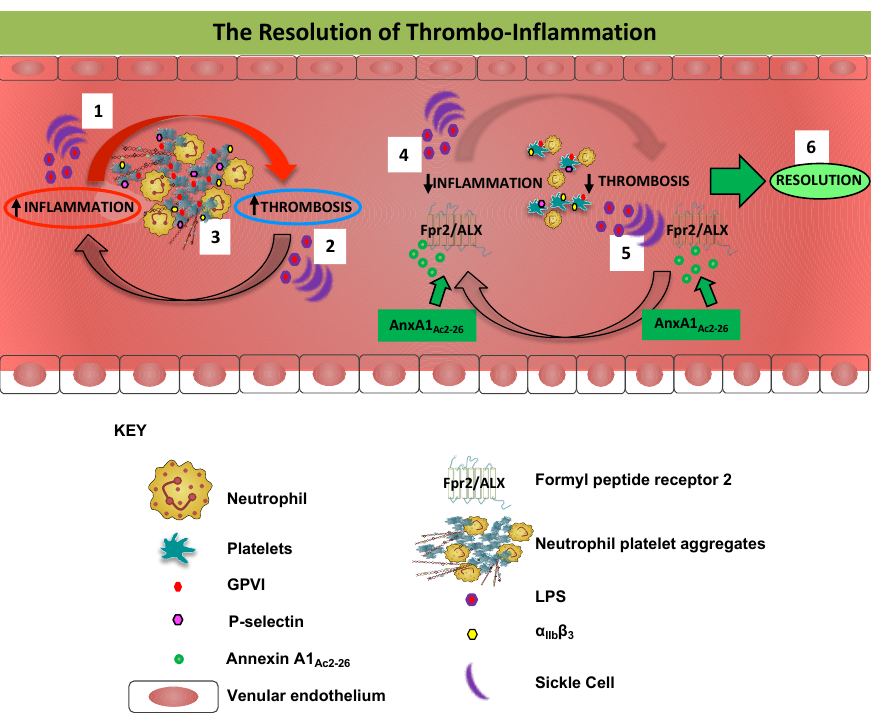
Figure 5. Anti-inflammatory and pro-resolving e ff ects of targeting the AnxA1 / Fpr2 / ALX pathway against thrombo-inflammation. Thrombo-inflammatory conditions such as sepsis [35] and sickle cell disease (SCD) [71] induce inflammation (Box 1) as well as thrombus formation (Box 2) in the cerebral microcirculation enabling thrombo-inflammation (as indicated by e.g., heightened platelet GPVI, α IIb β 3 and P-selectin expression, and increased platelet–platelet (homotypic) aggregates and platelet-neutrophil (heterotypic) aggregates). Neutrophils also produce neutrophil extracellular traps (NETs) which can exacerbate thrombo-inflammation (Box 3). AnxA1 Ac2-26 inhibits lipopolysaccharide (LPS) and SCD-induced cerebral inflammation (Box 4) and cerebral thrombosis (Box 5) via Fpr2 / ALX. The AnxA1 peptide a ff ords protection by altering the haemostatic action of platelets, modulating platelet cell surface molecules elicited by GPVI (e.g., α IIb β 3 and P-selectin), and reducing platelet (homotypic and heterotypic) aggregation. Thus, AnxA1 Ac2-26 promotes the resolution of thrombo-inflammation by reducing platelet activation, adhesion, and aggregation which cause and promote thrombosis (Box